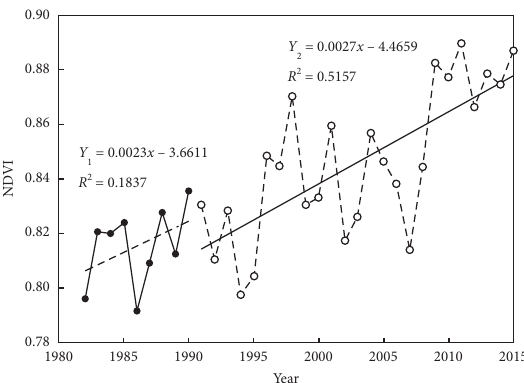
Figure 6: Variation in NDVI in the Yue River watershed during